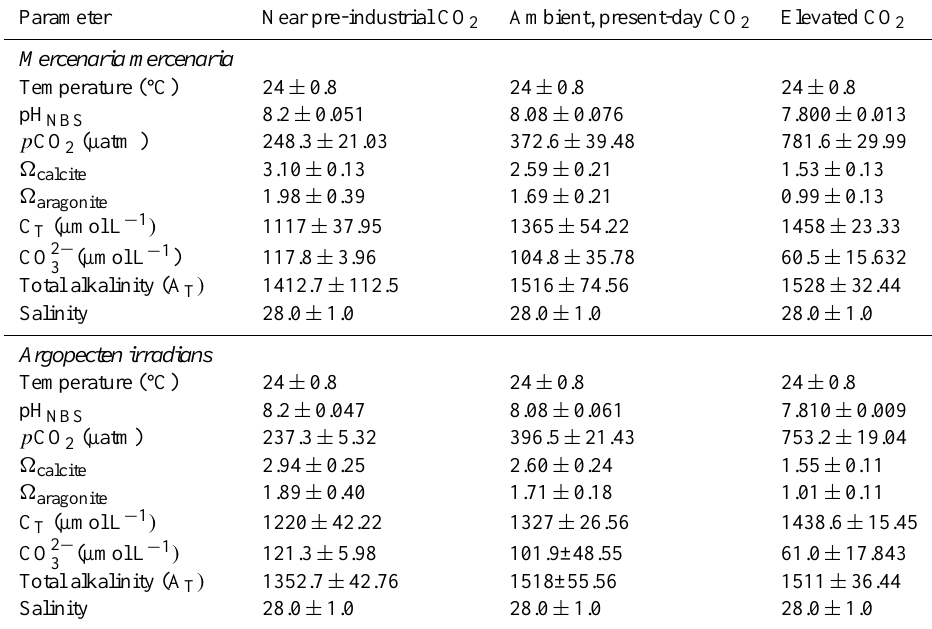
Table 1. Mean temperature, pH, carbonate chemistry, total alkalinity, and salinity (1SD) during the three-level carbon dioxide experiments for calcium uptake with Mercenaria mercenaria and Argopecten irradians larvae.